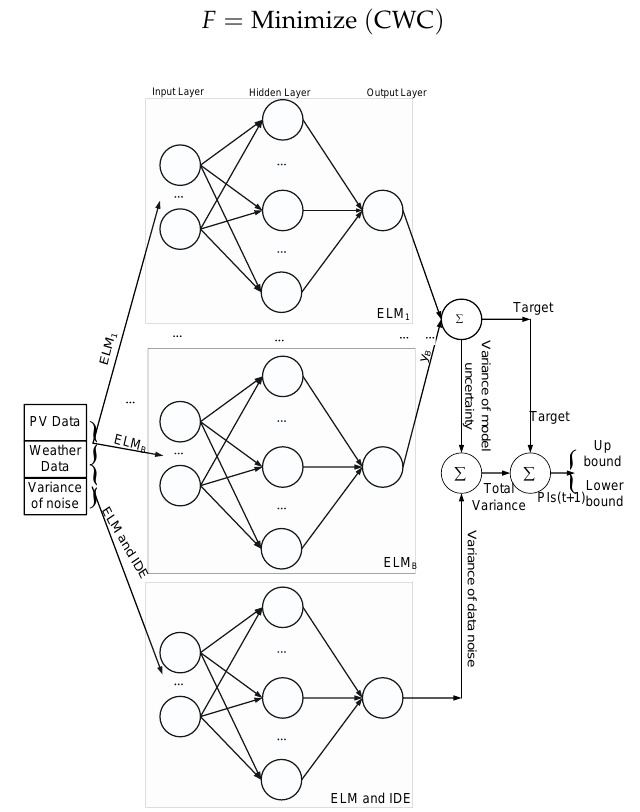
Figure 2. Diagram of proposed approach.